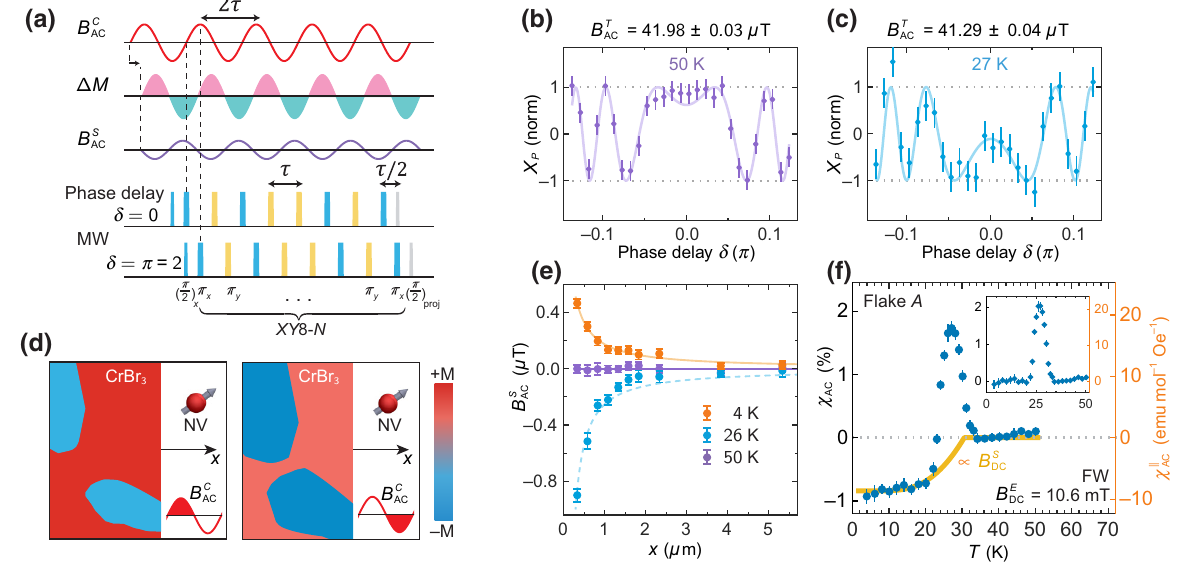
FIG. 3. ac susceptometry technique. (a) Experimental sequence: an oscillating coil field (cid:2) B C excites an ac magnetization change (cid:7) M ac (with a possible phase shift) in the CrBr 3 flake. An XY8- N dynamical decoupling sequence is applied to the NV center to lock-in = B C + B S along the NV axis due to both the coil and the sample. The phase delay δ between (cid:2) B C and the to the total ac field B T ac ac ac ac microwave (MW) pulses can be tuned to isolate either the in-phase ( δ = 0) or out-of-phase ( δ = π/ 2) magnetization response. (b) The at 50 K for Flake A determined from the fringe pattern around δ = 0 in the x projection, X P , of the NV superposition state field B T ac = 10.6 mT using an XY8- N 2 sequence with f = 238 kHz. (c) The after precession due to the ac fields. The data are acquired at B E ac dc at 27 K. (d) Schematic showing the microscopic mechanisms for (cid:7) M . The field (cid:2) B C causes domain wall displacements or field B T ac ac ( = B T − B C ) away from Flake A’s right edge. A magnetization rotation in the sample. (e) Linecut of the sample’s ac stray field B S ac ac ac is determined from the 50 K data and is subtracted from all three data sets. The positive B S at linear background for the coil field B C ac ac 4 K is an artifact induced by the flake’s dc stray field (cid:2) B S . (f) Main: temperature dependence of the uncorrected ac susceptibility χ ac dc / B C for Flake A during field warming (FW) from a saturated state. The left y axis, χ ac , is defined as − B S , while the right y axis, χ (cid:7) ac , ac ac is a quantitative estimate for the ac susceptibility parallel to the c axis. The yellow curve represents the baseline for the susceptibility and is proportional to B S . Inset: baseline-corrected χ ac due to the physical ac magnetization dc